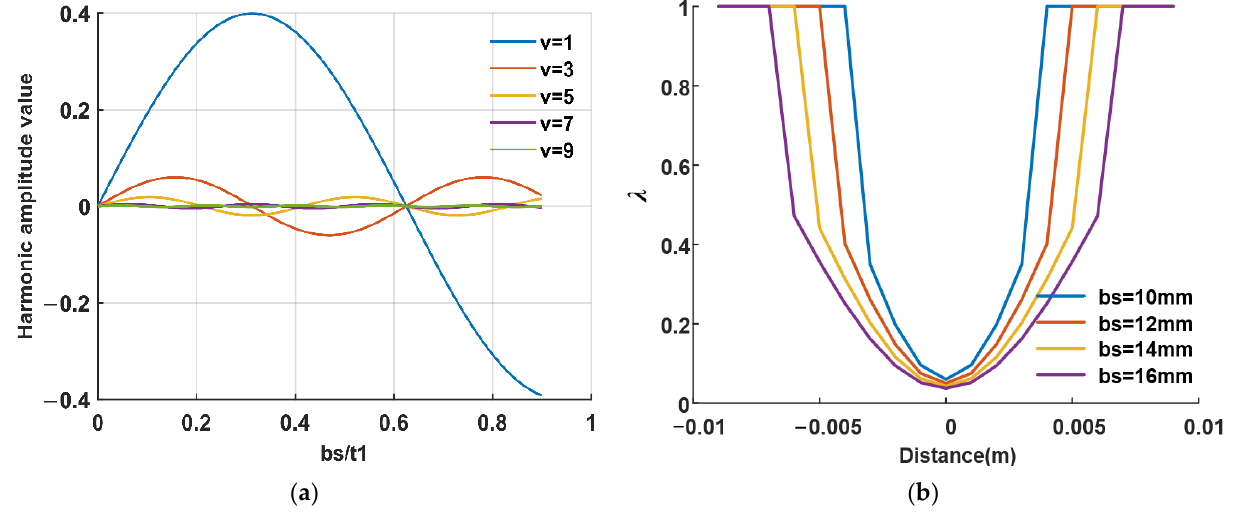
Figure 11. Distribution of harmonic amplitude and magnetic field density at different slot spacing ratios. ( a ) Harmonic amplitude value; ( b ) single-slot flux density distribution.